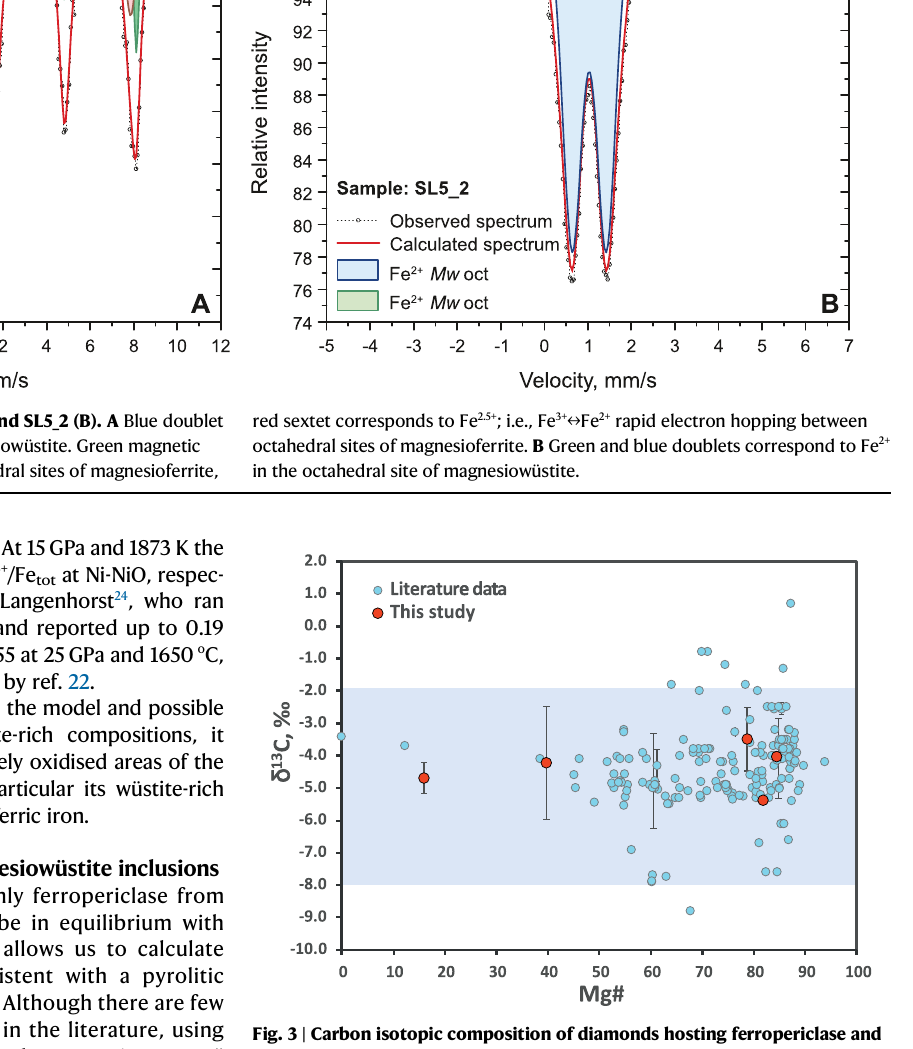
Fig. 3 | Carbon isotopic composition of diamonds hosting ferropericlase and magnesiowüstiteinclusions. Inlightblueisshownthemantlerange 30 .References to literature data are listed in Supplementary